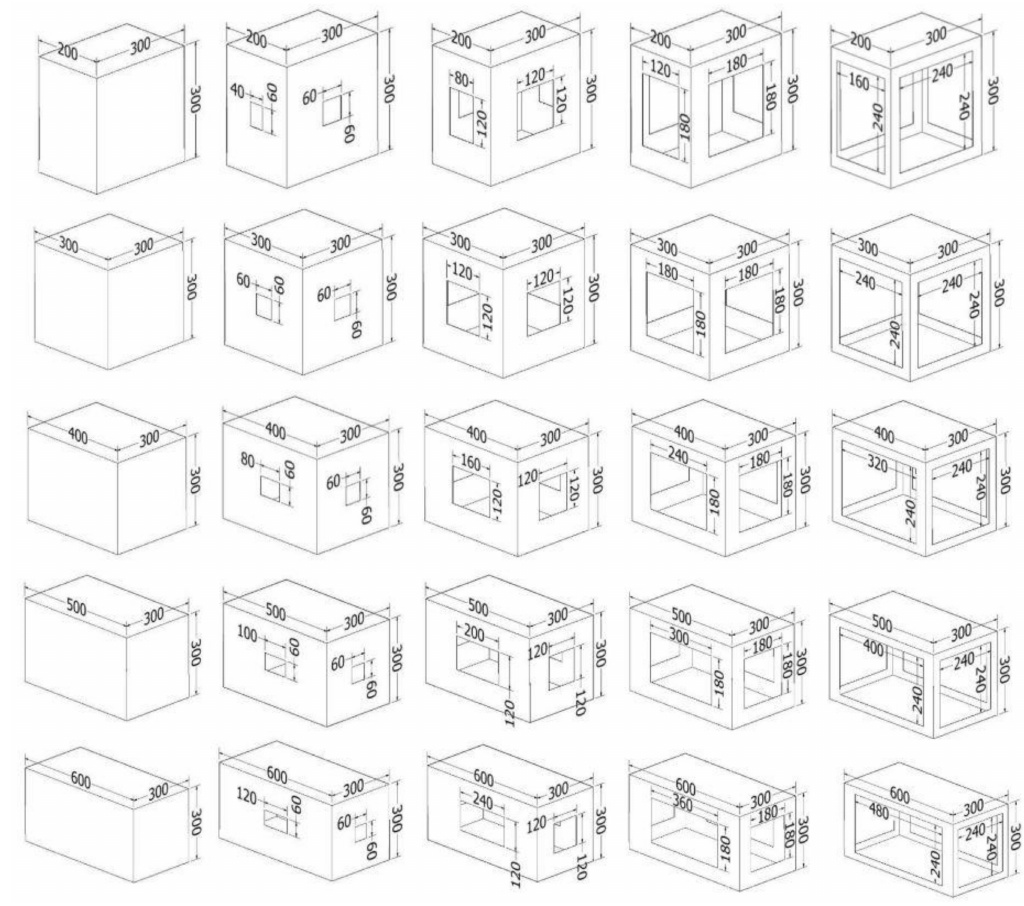
Figure 3. Five types of cutouts used on samples with different dimensions.